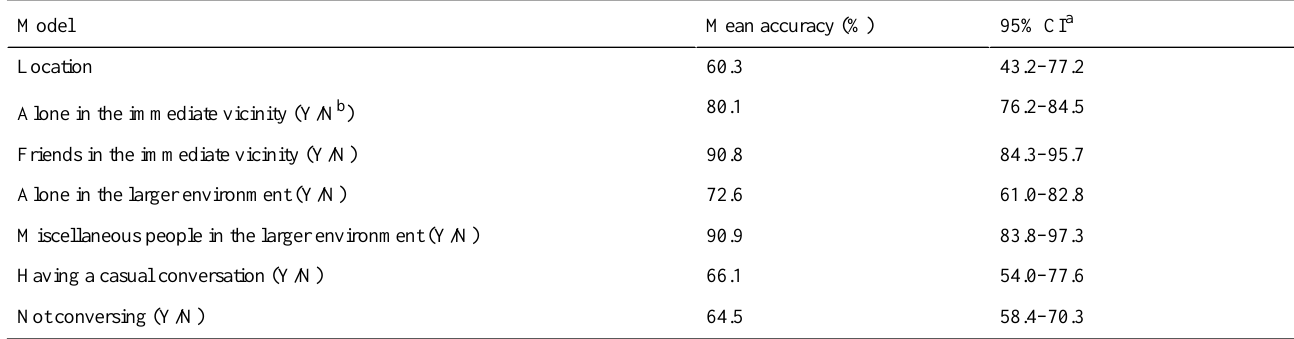
Table 1. Mean accuracy indicators for machine learning models of categorical states common to all treatment completers (N =